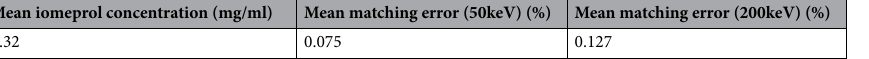
Mean iomeprol concentration (mg/ml)